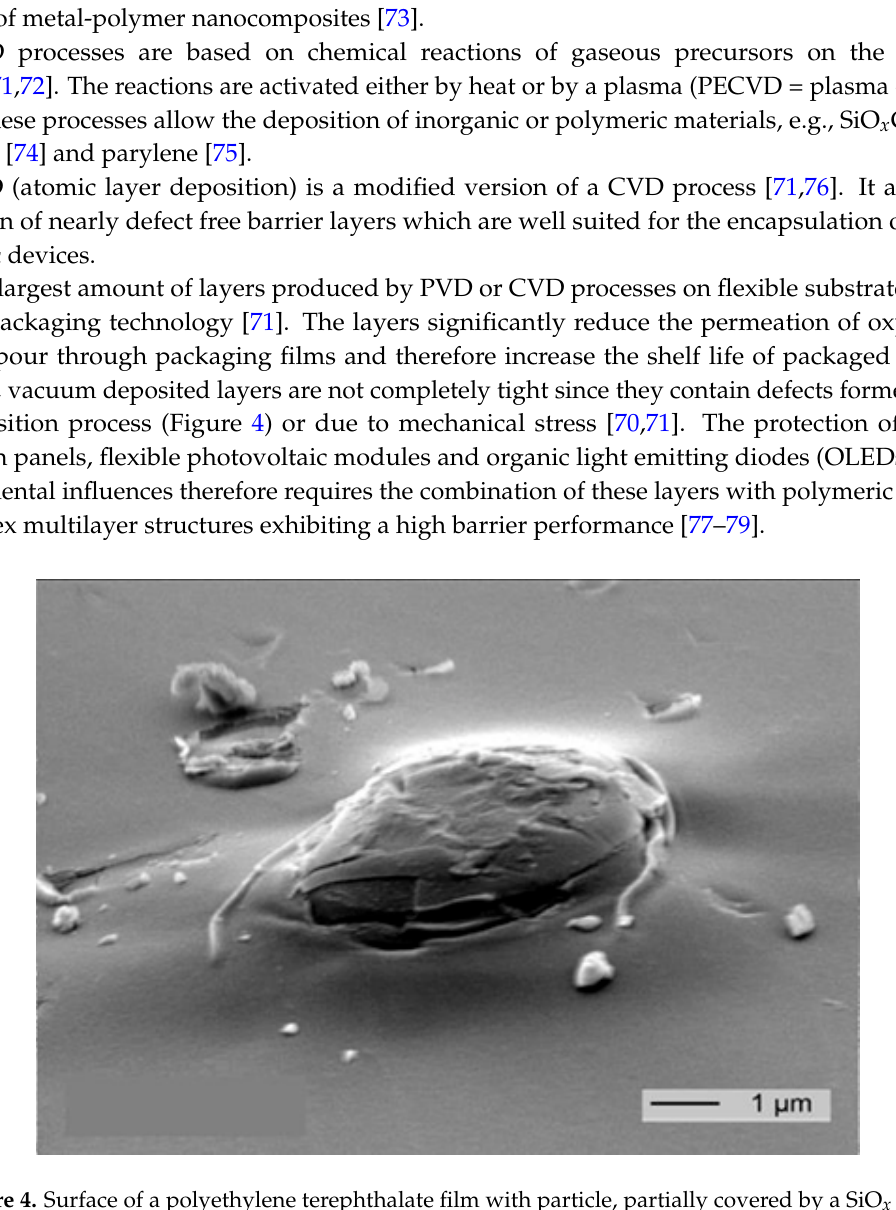
Figure 4. Surface of a polyethylene terephthalate film with particle, partially covered by a SiO x layer (Source: Fraunhofer IVV) [80].